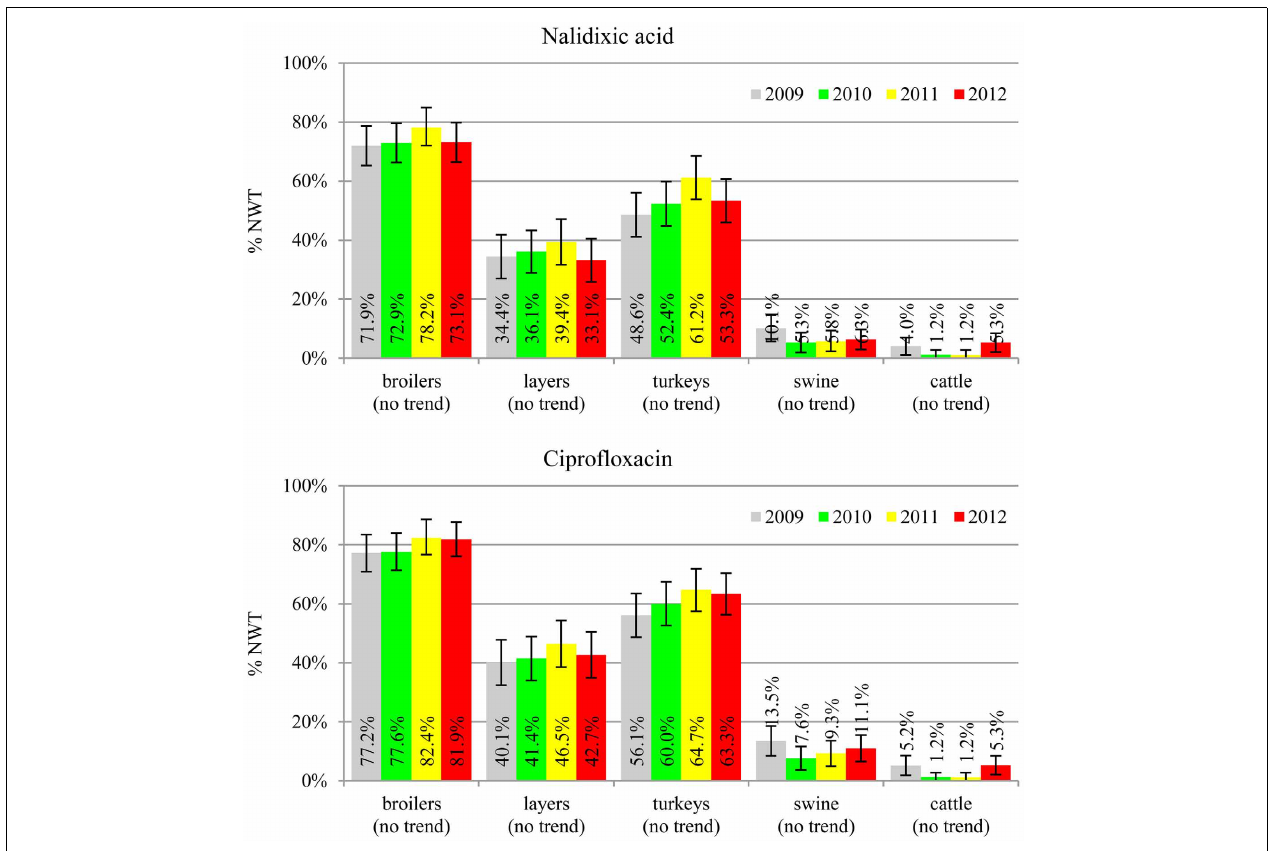
FIGURE 2 | Microbiological resistance to quinolones and fluroquinolones.